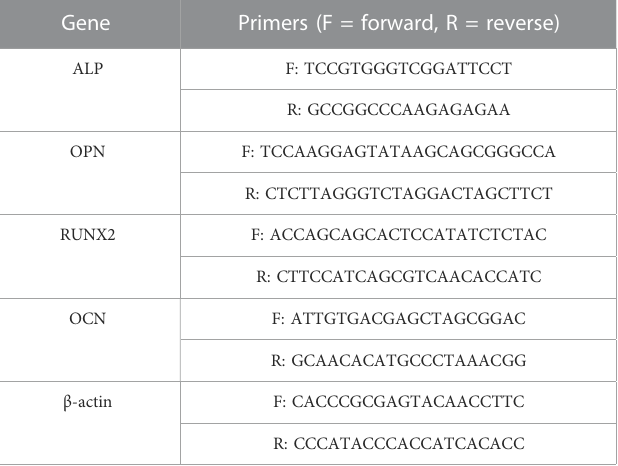
TABLE 1 Primer pairs used in real-time PCR analysis. Gene Primers (F = forward, R =